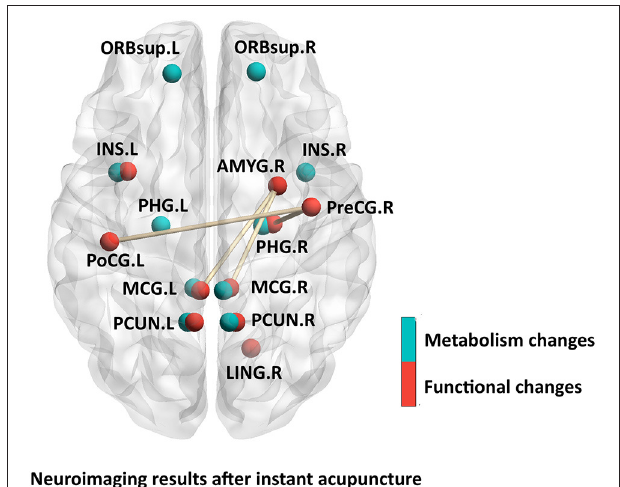
FIGURE 3 | Neuroimaging results after instant acupuncture.